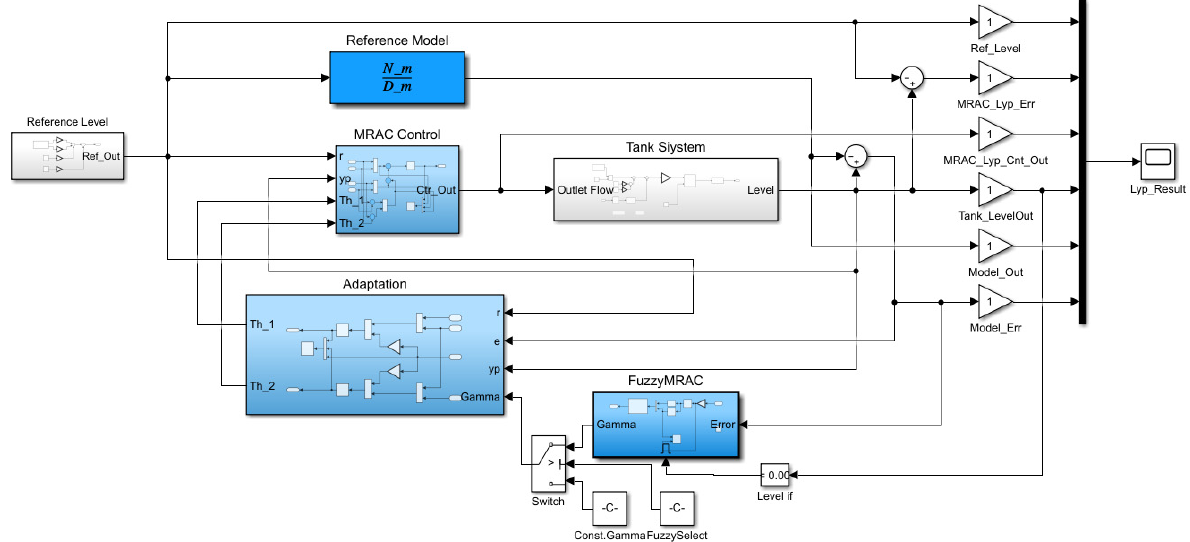
Figure 7. Two-input fuzzy MRAC model.